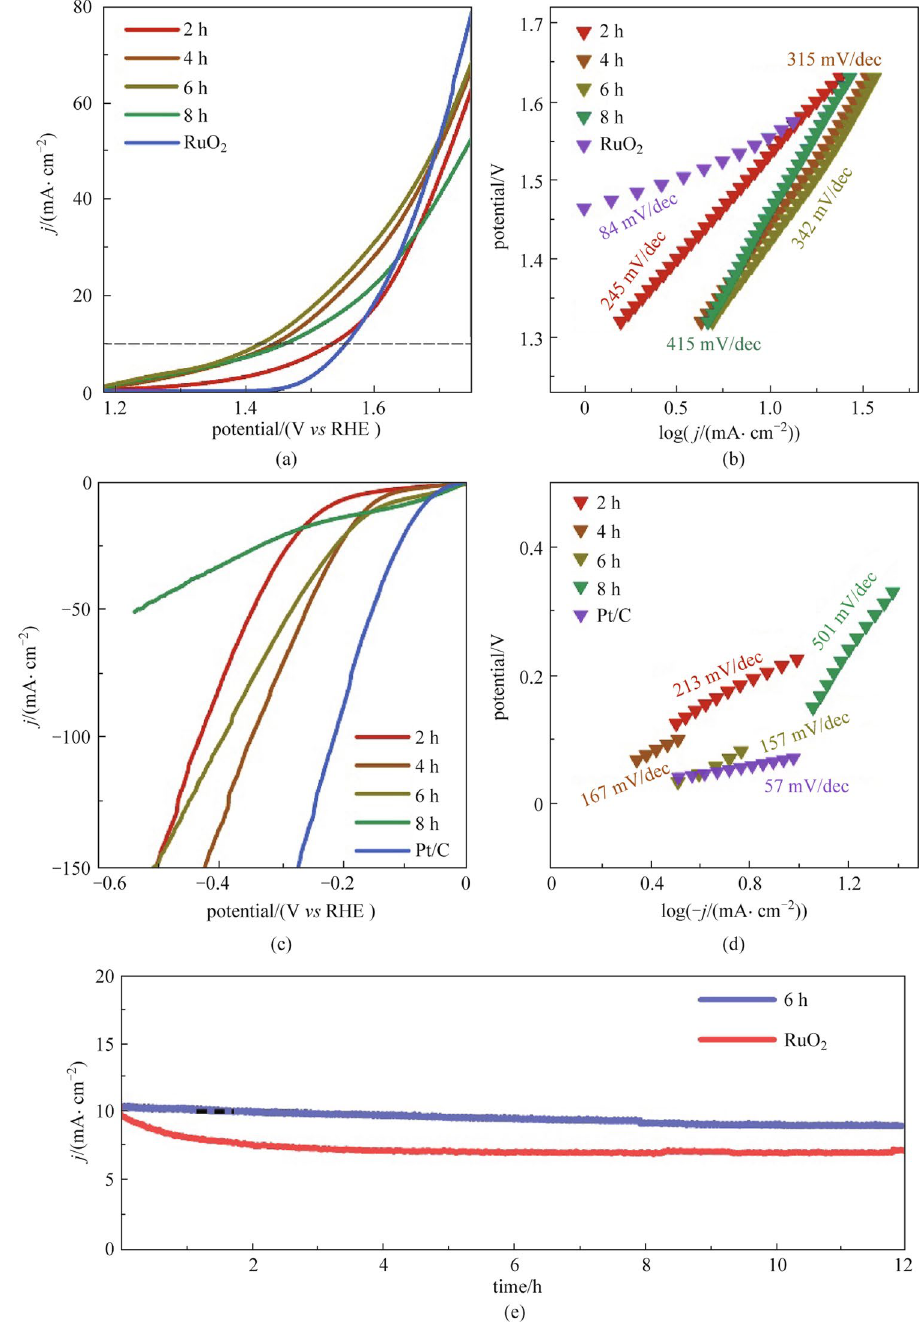
Fig. 6 Electrochemical testing of RuO 2 and MOS/COS/CC electrocatalysts with different synthesis time. a LSV curves of OER. b Tafel curves of OER. c LSV curves of HER. d Tafel curves of HER. e Stability test of MOS/COS/CC-6 h and RuO 2